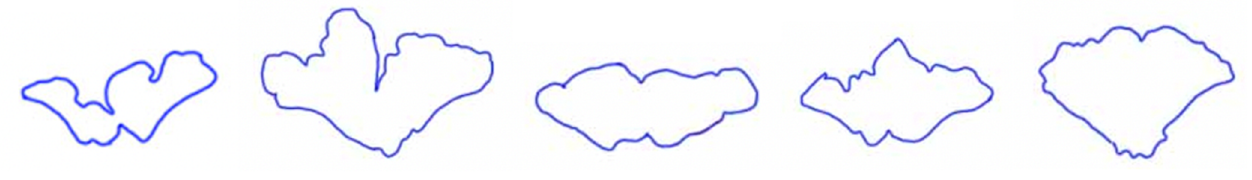
Figure 3. Examples of outermost blue outlines of frontal sinuses saved as BITMAP files.